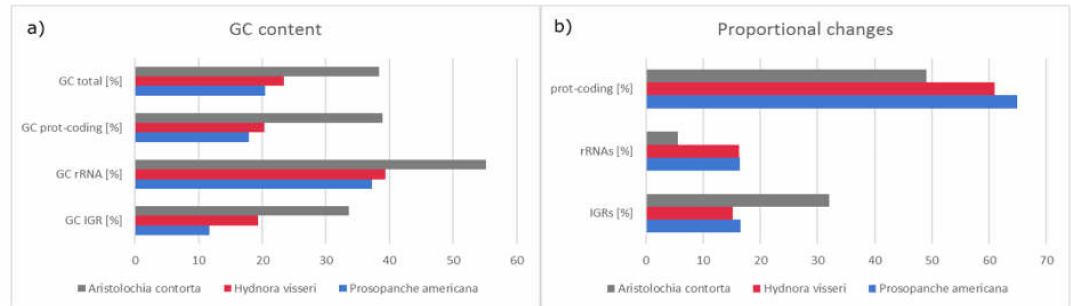
Figure 4. Prosopanche americana has a low GC content. ( a ) Comparison of the GC content and ( b ) proportional changes of plastid genome compartments (protein coding, ribosomal RNA, intergenic region) among the photosynthetic Aristolochia contorta (Aristolochiaceae, NC_036152) and the holoparasitic Hydnoraceae highlighting the extent of changes the plastomes of the Hydnoraceae have undergone with respect to nucleotide composition and conservation of specific genome